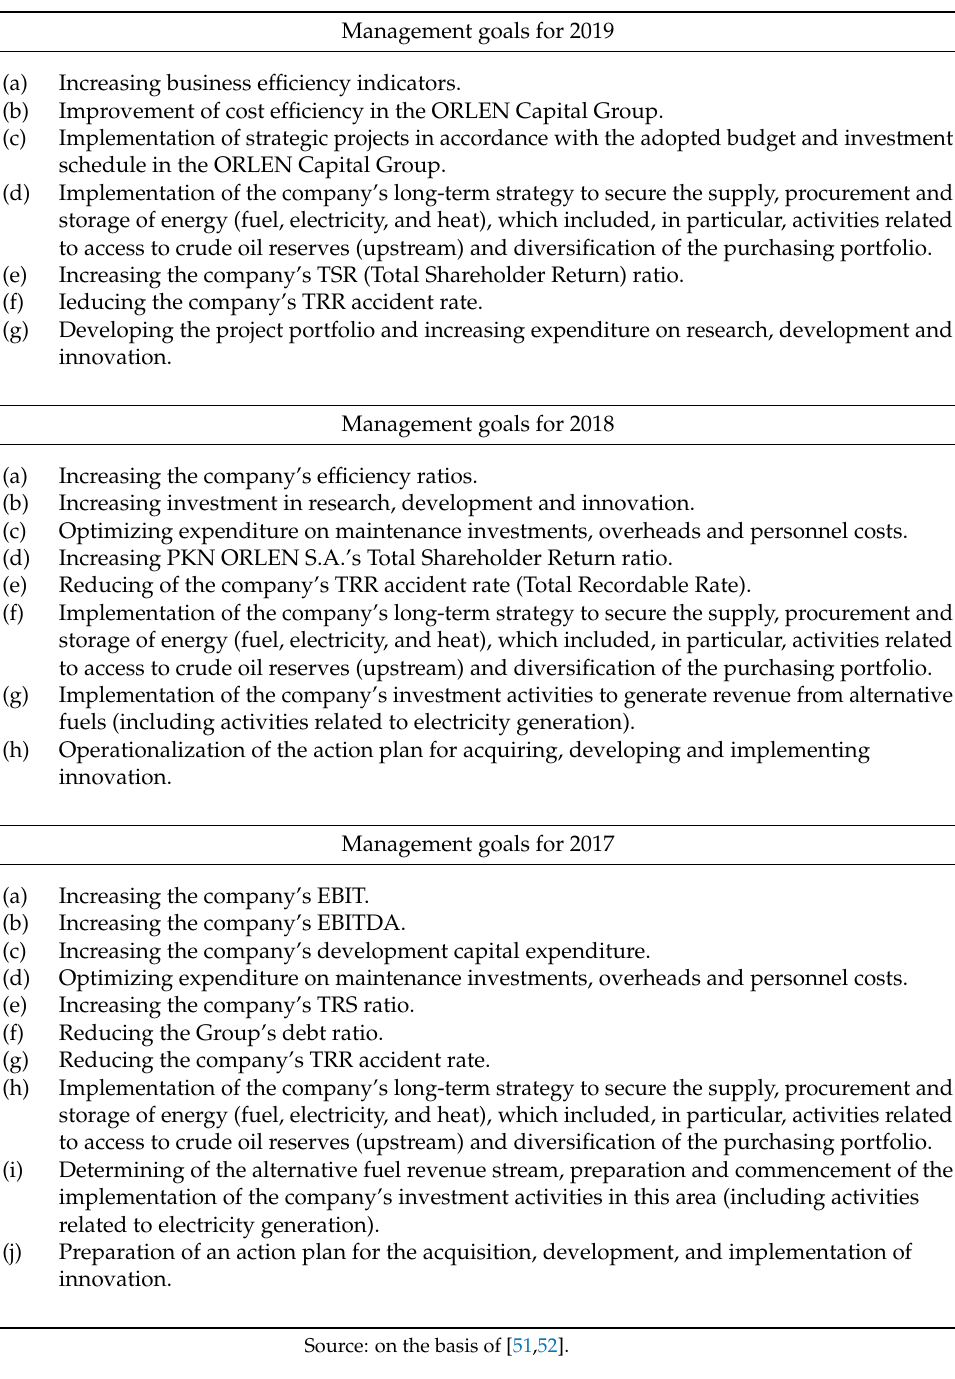
Table 4. Management goals of PKN Orlen S.A. for 2017–2019 and the following